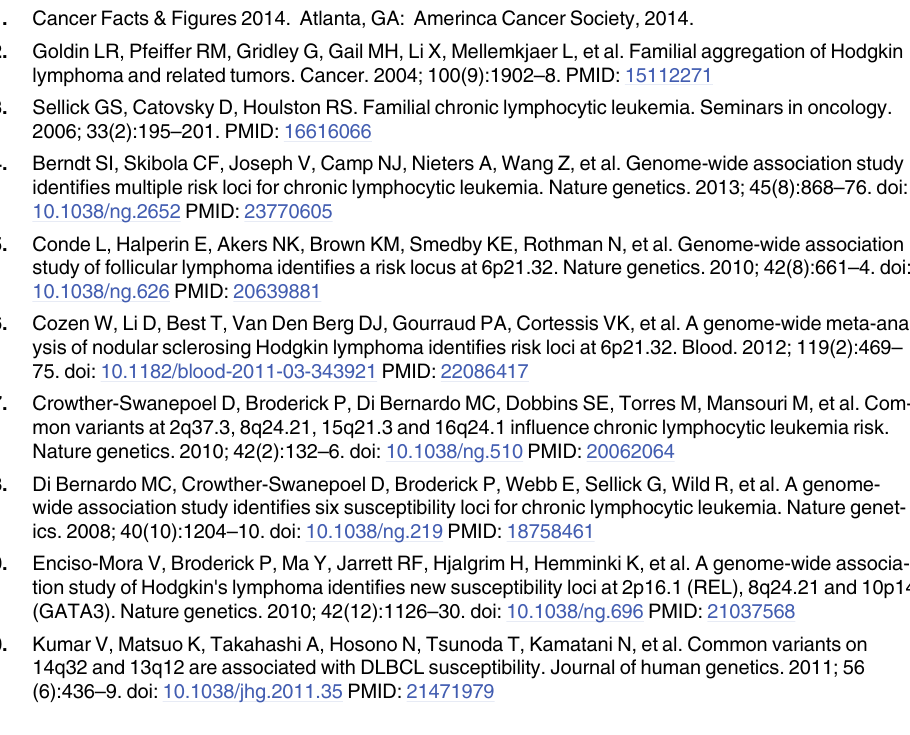
S9 Table. Enrichment scores calculated for Roadmap Epigenomics transcription start site segmentation data. Sorted according to p-value for r 2 > 0.8.